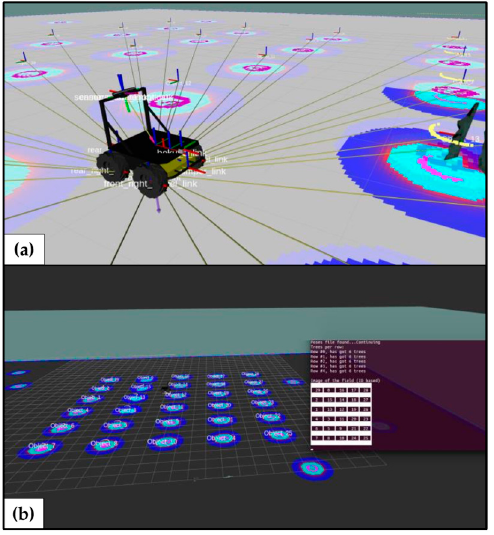
Figure 9. AgROS’s geospatial mapping process: ( a ) real-time localization of trees; and ( b ) recording of every tree on the field.